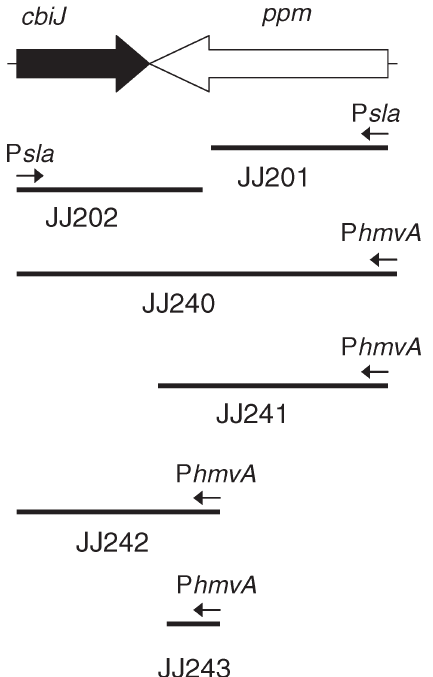
Figure 5. Overexpression of ppm-cbiJ in Methanococcus maripalu- dis . The lines indicate the DNA fragments cloned into the vectors for overexpression. JJ201 and JJ202 were transformedby expressionvec- tors designed to integrate into the genome, placing the promoters up- stream of ppm and cbiJ , respectively. JJ240–JJ243 were transformed by shuttle vectors containing the indicated cloned DNA. P sla and P hmv A represent promoter sequences for the S-layer gene and a histone gene in Methanococcus voltae , respectively. Both promoters are believed to be highly expressed in M. maripaludis